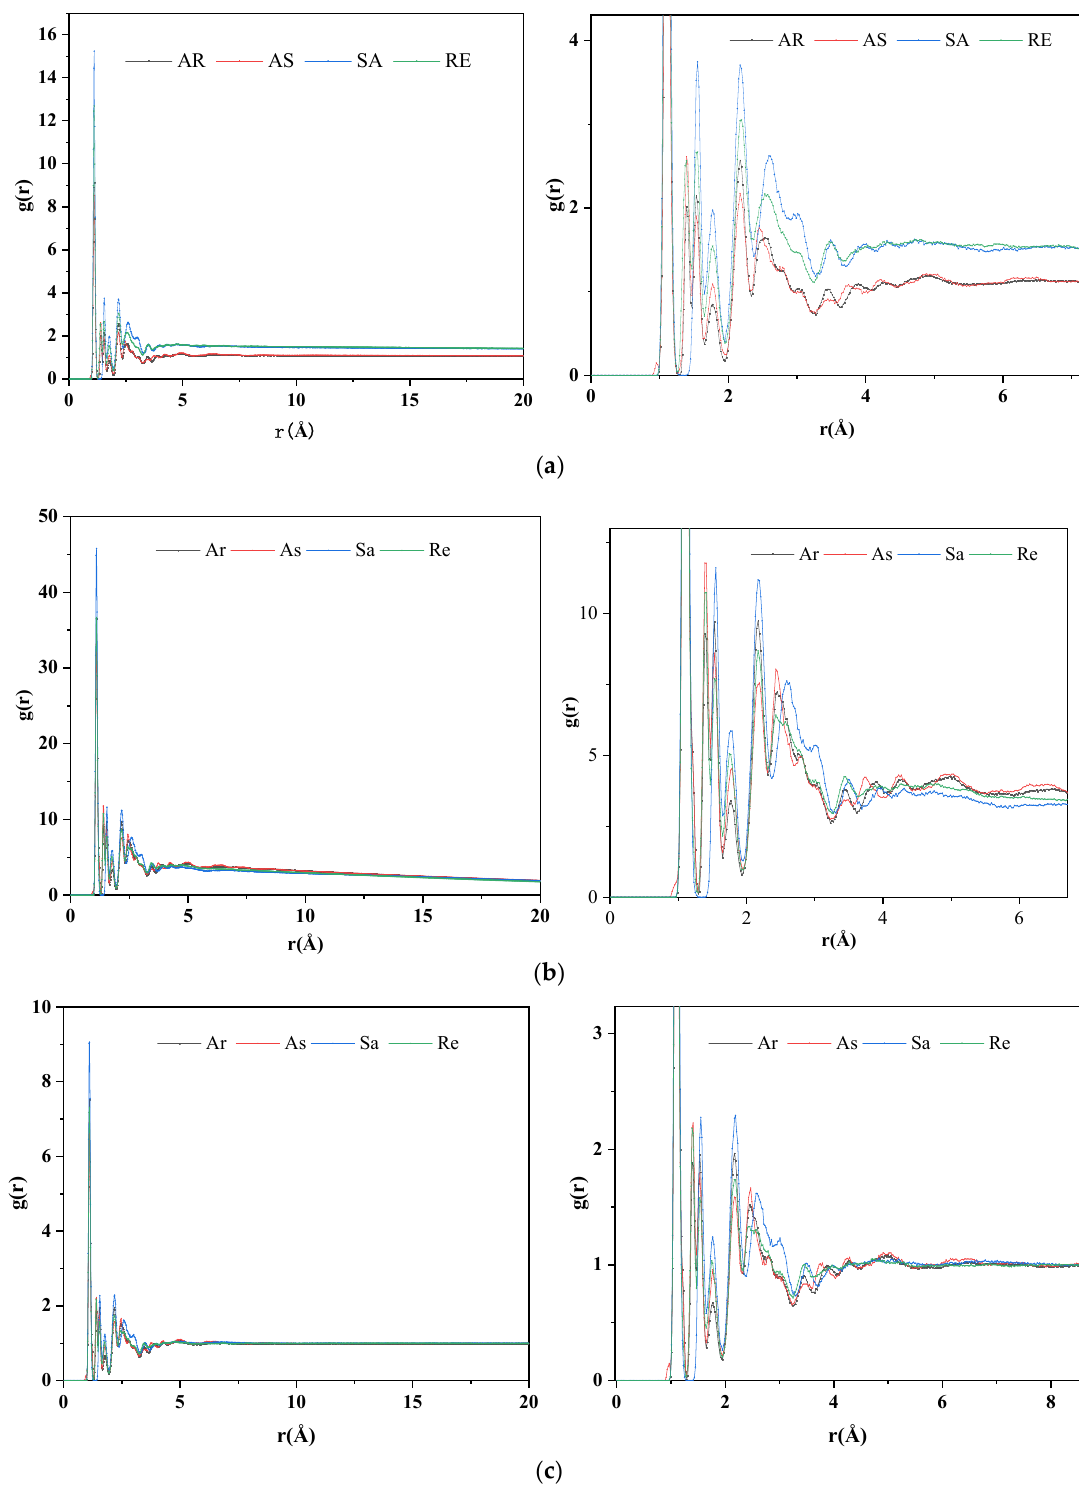
Figure 12. RDF results for asphalt. ( a ) BA. ( b ) Aged asphalt. ( c ) Rejuvenated asphalt. We used the analysis of the forcite module in the software to analyze the model, calculate the movement of the four components of BA, aged asphalt, and rejuvenated asphalt, and fit the data in the time range of 0 ps to 150 ps with a straight line. The results are shown in Figure 13.